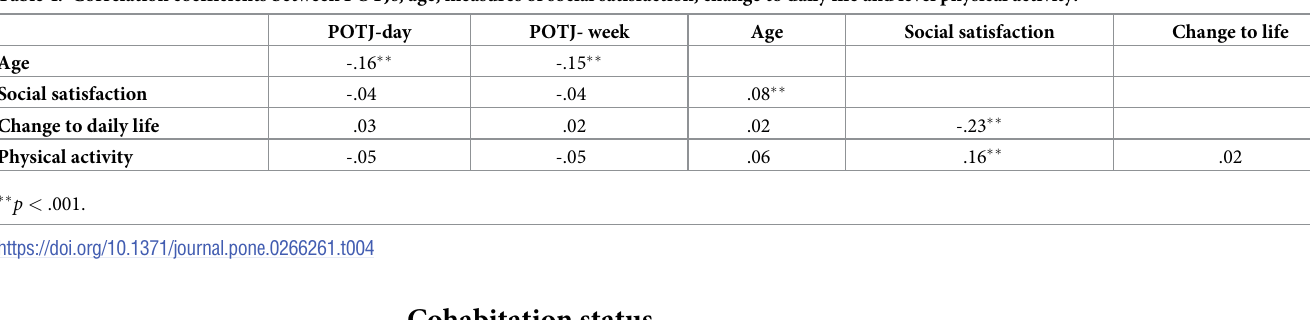
Table 4. Correlation coefficients between POTJs, age, measures of social satisfaction, change to daily life and level physical activity.